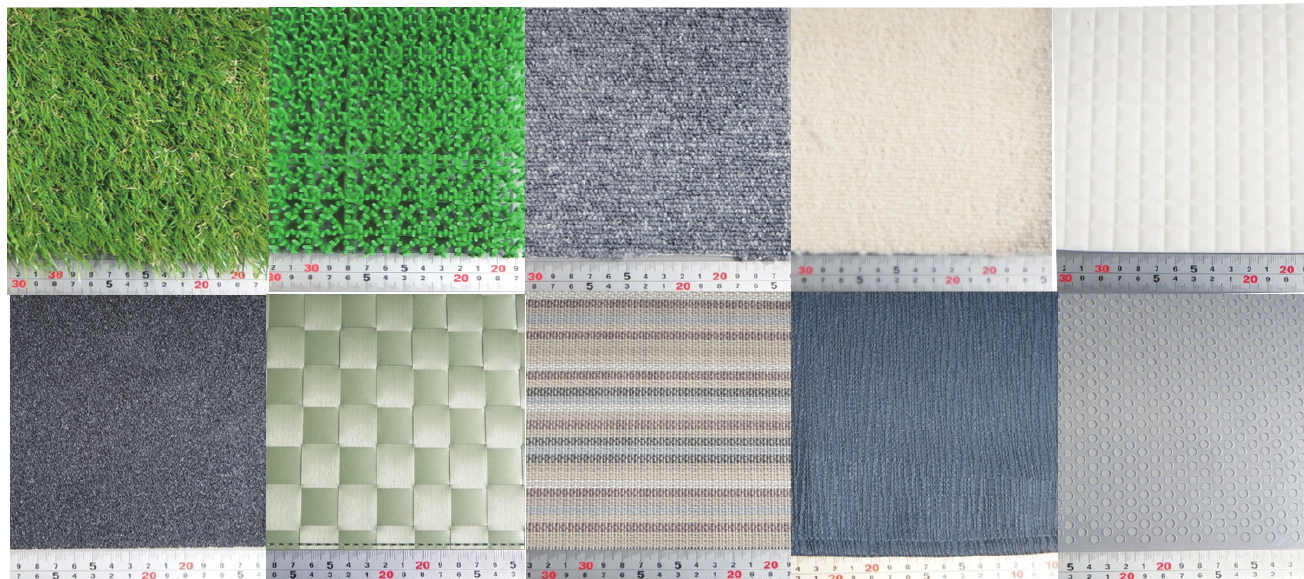
Figure 7. Textures used in the